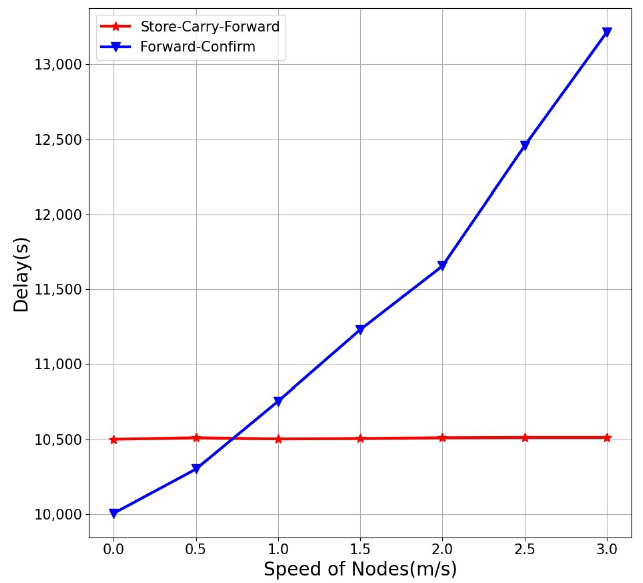
Figure 15. The AUV energy consumed of “Store-Carry-Forward” and “Forward-Confirm” in different speed of